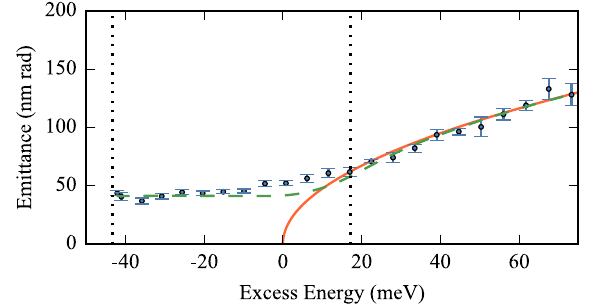
FIG. 2. Electron beam normalized RMS emittance for a range of excess energies for two-dimensional pepperpot measurements (blue circles), analysis of results from a simulation (green dashed line), and calculated using Eq. (3) (solid red line). Excess ionization energy below zero indicates below-threshold field- ionization. The left dotted line indicates the excess energy of the long duration streaked bunch in Fig. 3, and the right is that of the short duration bunch.